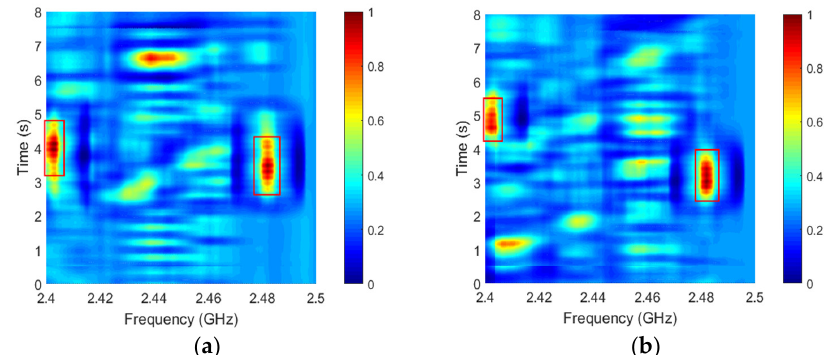
Figure 26. The HOC method results for two UAVs indoors at distances of ( a ) 5 m and ( b ) 10 m.